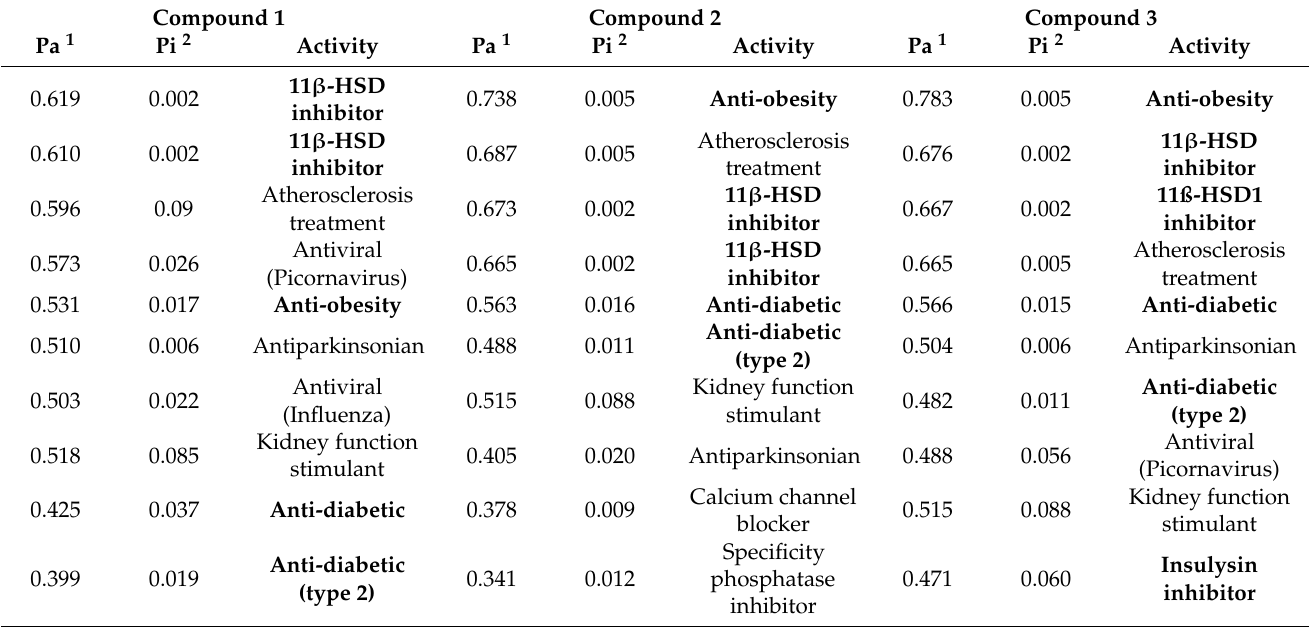
Table 5. Top 10 PASS predictions for the activity spectrum of compounds 1 , 2 and 3